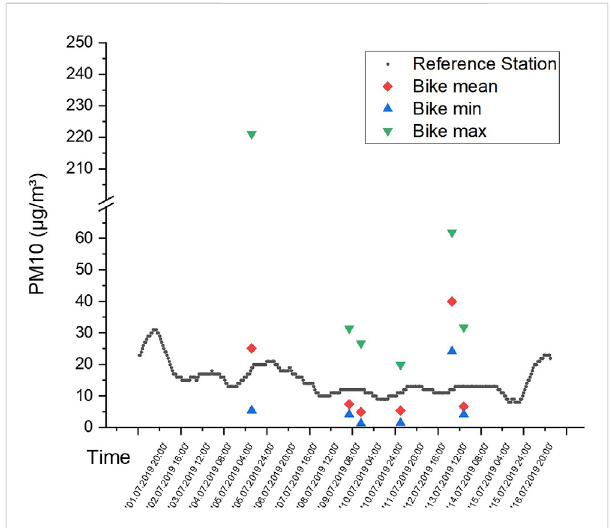
PM 10 concentrations at an automatically recording air quality station operated by the State of Baden-Württemberg at Karlsruhe- Southwest (Reinhold-Frank-Straße) (data base query from https:// www.umweltbundesamt.de/daten/luft/luftdaten/luftqualitaet, access 09/01/20) and mean, min and max bike tour